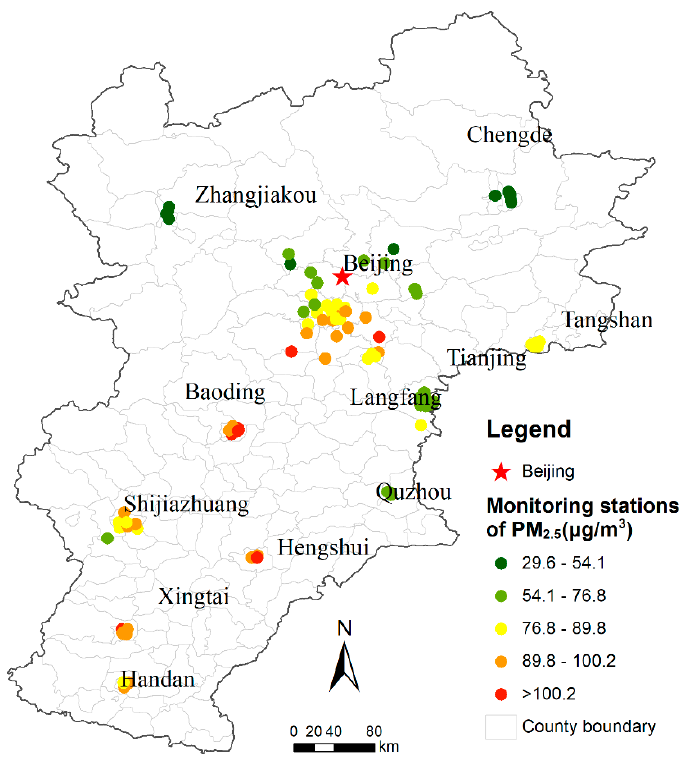
Figure 1. Study region of Jing-Jin-Ji metropolitan region.